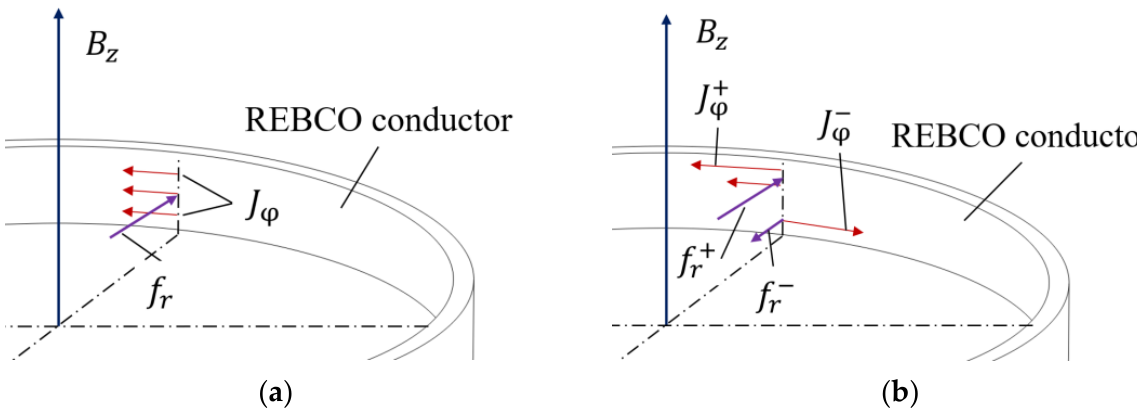
Figure 4. The effect of screening current on stress condition. ( a ) Stress condition without screening current effect. ( b ) Stress condition considering screening current effect.